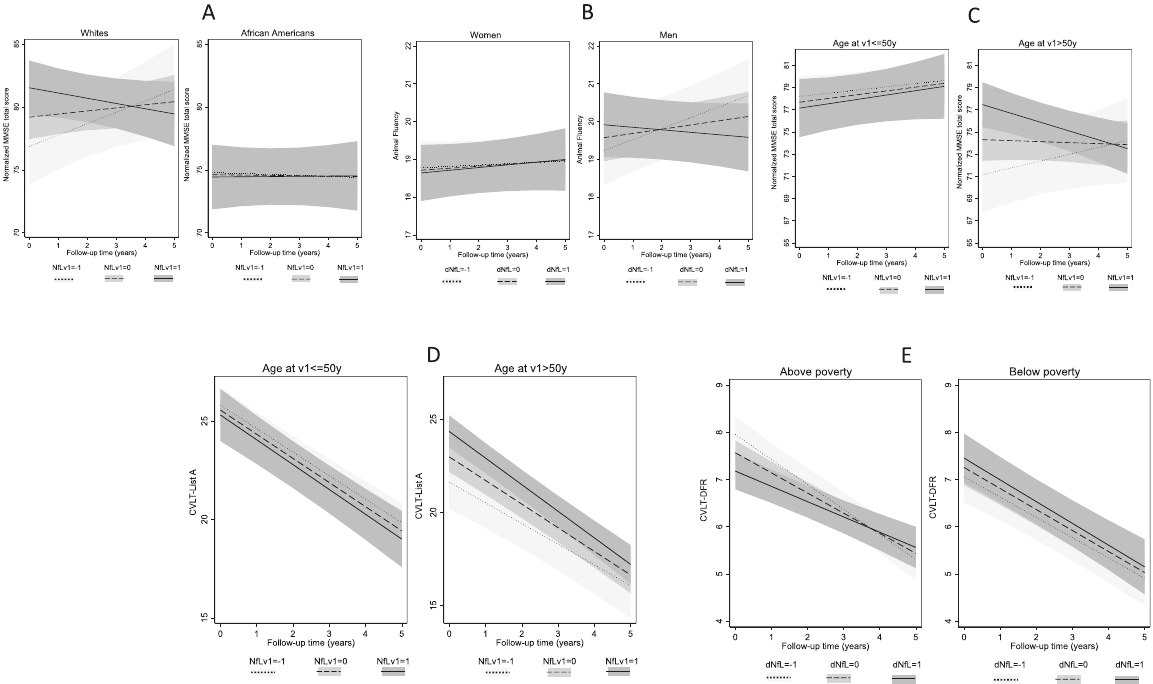
Fig. 2 Summary of key fi ndings by race, sex, age group, and poverty status across NfL exposures a,b . a NfLv 1 values are Log e transformed and z -scored. Levels of exposure are − 1: mean − 1 SD; 0: at mean; + 1: mean + 1 SD. 1 SD of baseline Log e (NfL) is estimated at 0.51; mean = 1.98. dNfL values are annualized changes in Log e transformed NfL between v 1 and v 2 , z-scored. 1 SD of annualized change in Log e (NfL) is estimated at 0.101; mean = 0.044. All test scores presented in these fi gures are coded in the direction of higher score → better performance. b A Predicted margins for normalized MMSE total score across NfLv1 are based on Model 1 among Whites and African Americans in Table 2; B predicted margins for animal fl uency scores across dNfL are based on Model 2 among women and men in Table S1; C predicted margins for normalized MMSE total score across NfLv1 are based on Model 1 among ≤ 50 y vs. >50 y age groups in Table S2; D predicted margins for CVLT- List A across NfLv1 are based on Model 1 among ≤ 50 y vs. >50 y age groups in Table S2; E predicted margins for CVLT-DFR across dNfL are based on Model 2 among “ above poverty ” vs. “ below poverty ” groups in Table S3. Abbreviations: AF Animal Fluency; BC baseline cognitive performance; CVLT-DFR California Verbal Learning Test-Delayed Free Recall; CVLT-List A California Verbal Learning Test-List A; dNfL z -scores